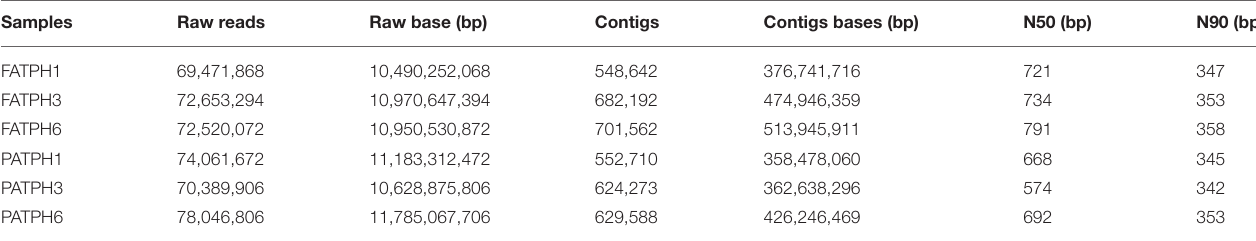
TABLE 1 | Sequencing information of the six samples.